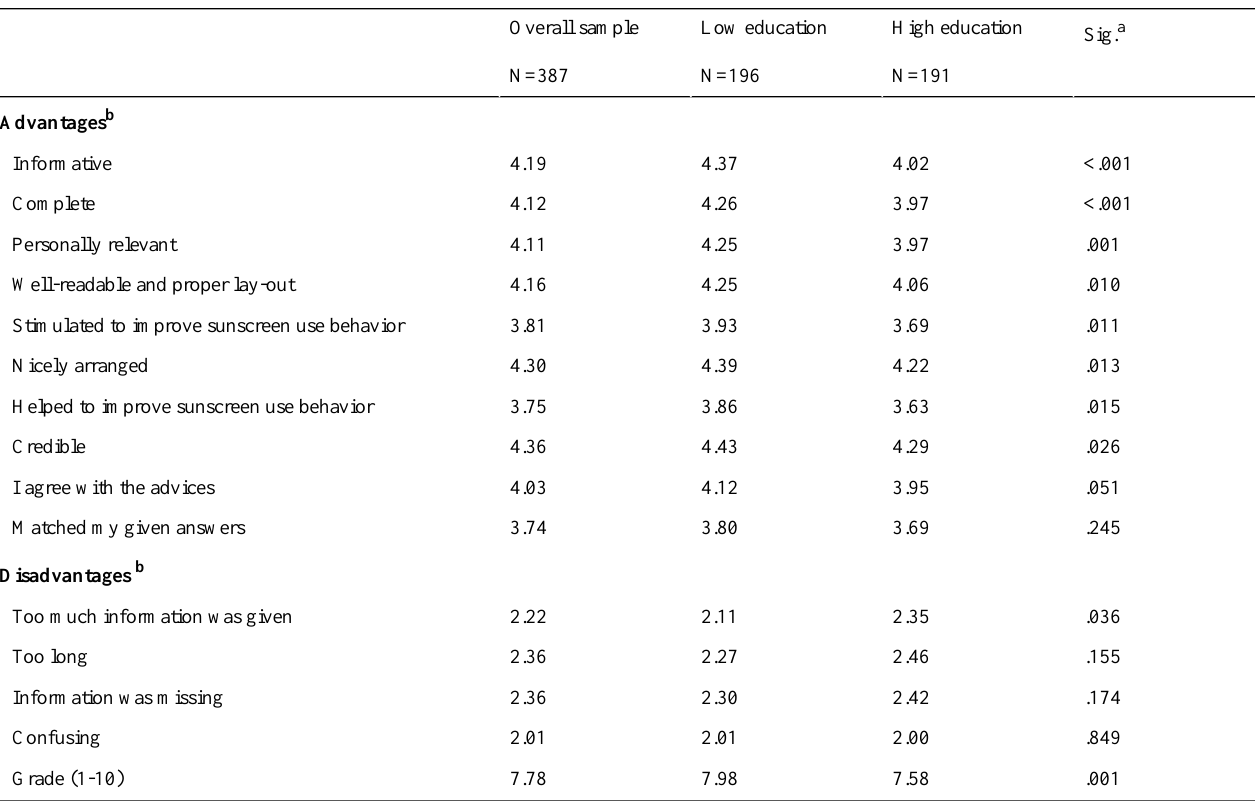
Table 3. Program evaluation based on